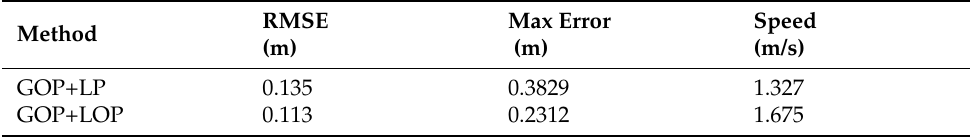
Table 2. Quantitative comparison of tracking control